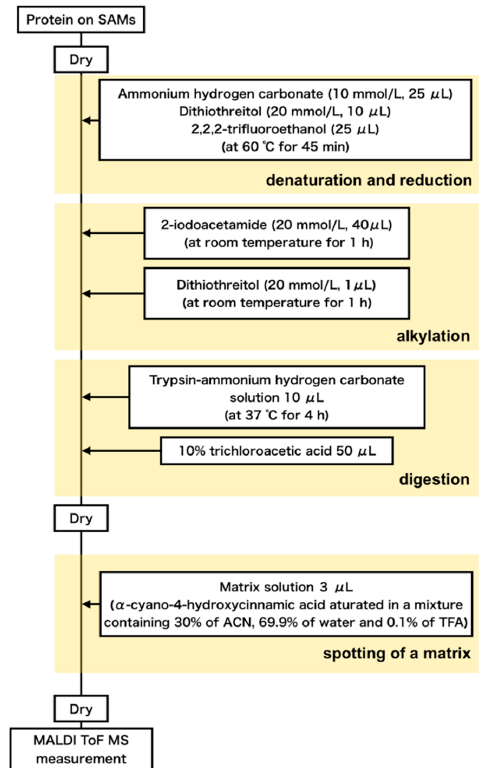
Figure 1. Flow of preparation of samples for MALDI-ToF mass spectroscopic measurements.